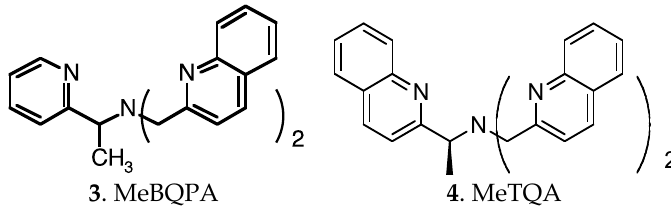
Figure 6. Structures of chiral TPA/TQA derivatives MeBQPA and MeTQA.